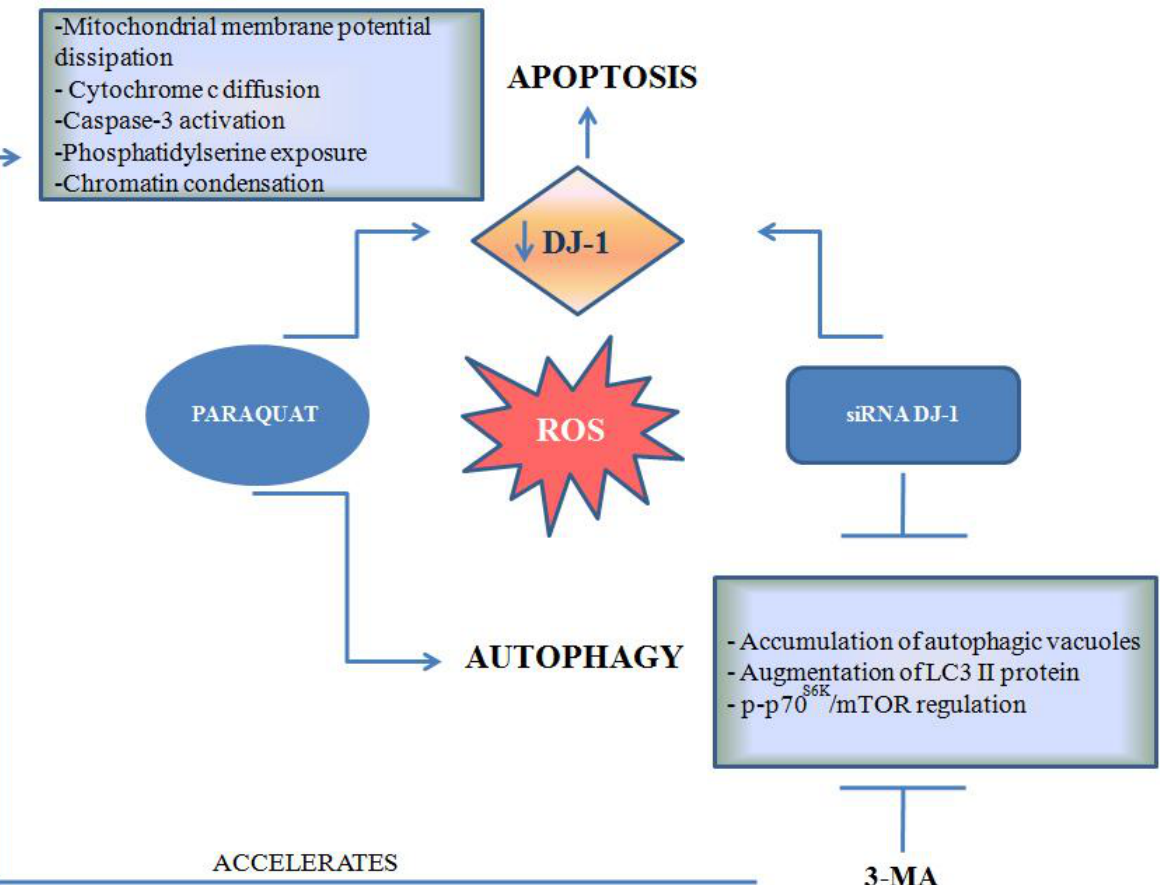
FIGURE 1 . Schematic of the connections between the DJ-1 protein and other factors in the PQ neurotoxicity model. The toxicity mediated by PQ is produced via ROS. In the first instance, the cell could activate an autophagic defense mechanism, including the accumulation of autophagic vacuoles and augmentation of LC3 II protein regulated via p-p70 S6K /mTOR. Later, however, coinciding with a decline in DJ-1 levels, the cells succumb to apoptotic death with mitochondrial membrane potential dissipation, cytochrome c diffusion, caspase-3 activation, phosphatidylserine exposure, and chromatin condensation. DJ-1 siRNA accelerated the apoptotic cell death induced by PQ to the extent that the autophagic defense response was inhibited. Autophagy inhibition with 3-MA accelerated the apoptotic cell death induced by the combination of